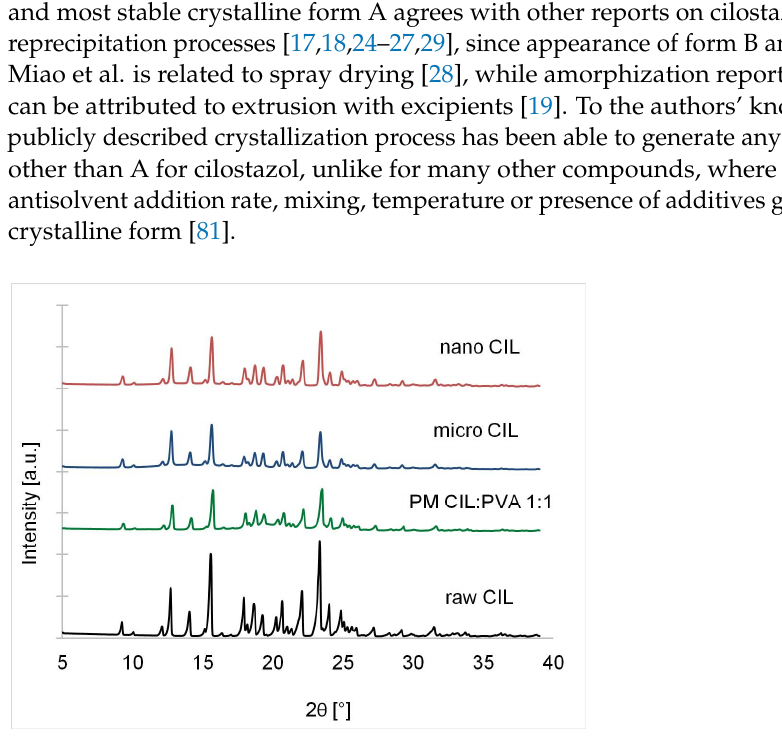
Figure 14. X-ray powder diffraction (XRPD) patterns of unprocessed cilostazol, its physical mixture (PM) with PVA, and micro- and nanocrystals.